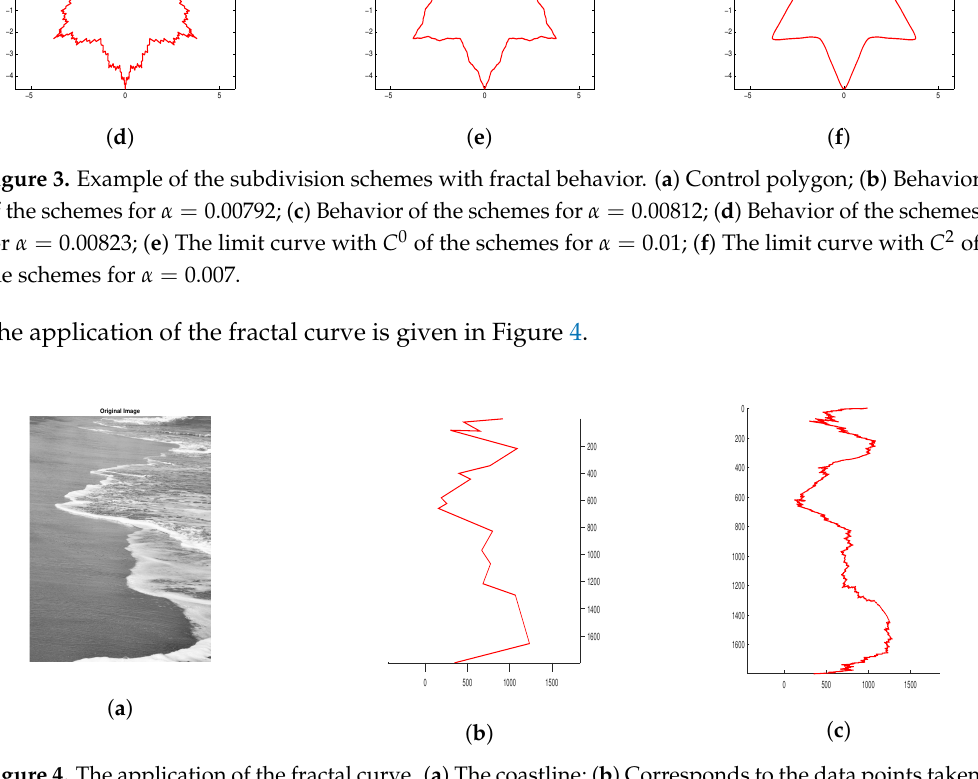
Figure 4. The application of the fractal curve. ( a ) The coastline; ( b ) Corresponds to the data points taken from (a); ( c ) The coastline is constructed by applying the subdivision scheme (5) to (b) for α = 0.00814. The continuous surface and the fractal surface is given in Figure